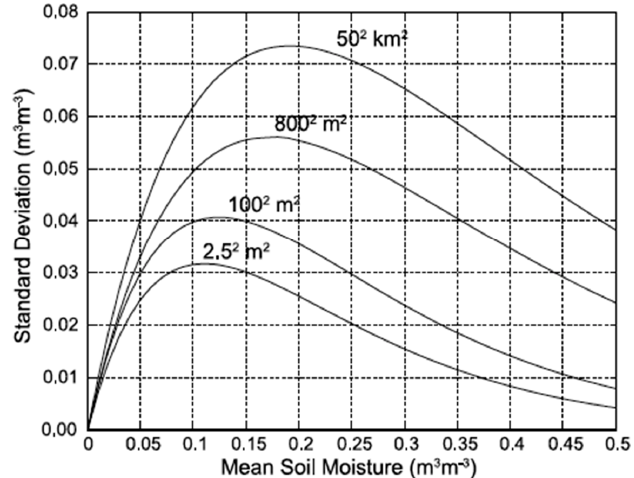
Figure 1. Relationships between the mean and standard deviation of point-scale soil moisture measurements sampled in different spatial extents (2.5 2 , 100 2 , 800 2 m 2 , and 50 2 km 2 ) [20].